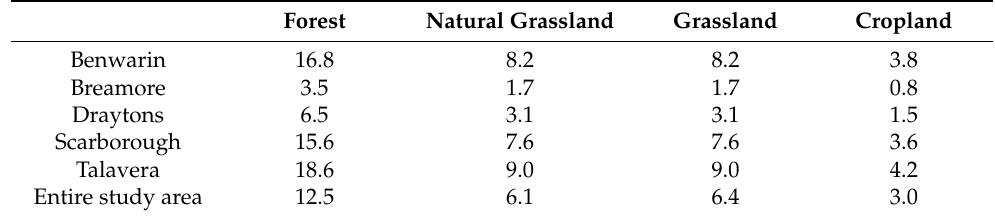
Table 2. The annual C inputs (t C ha − 1 yr − 1 ) from different plant residues for the 1970s–2016 period. Forest Natural Grassland Grassland Cropland Benwarin